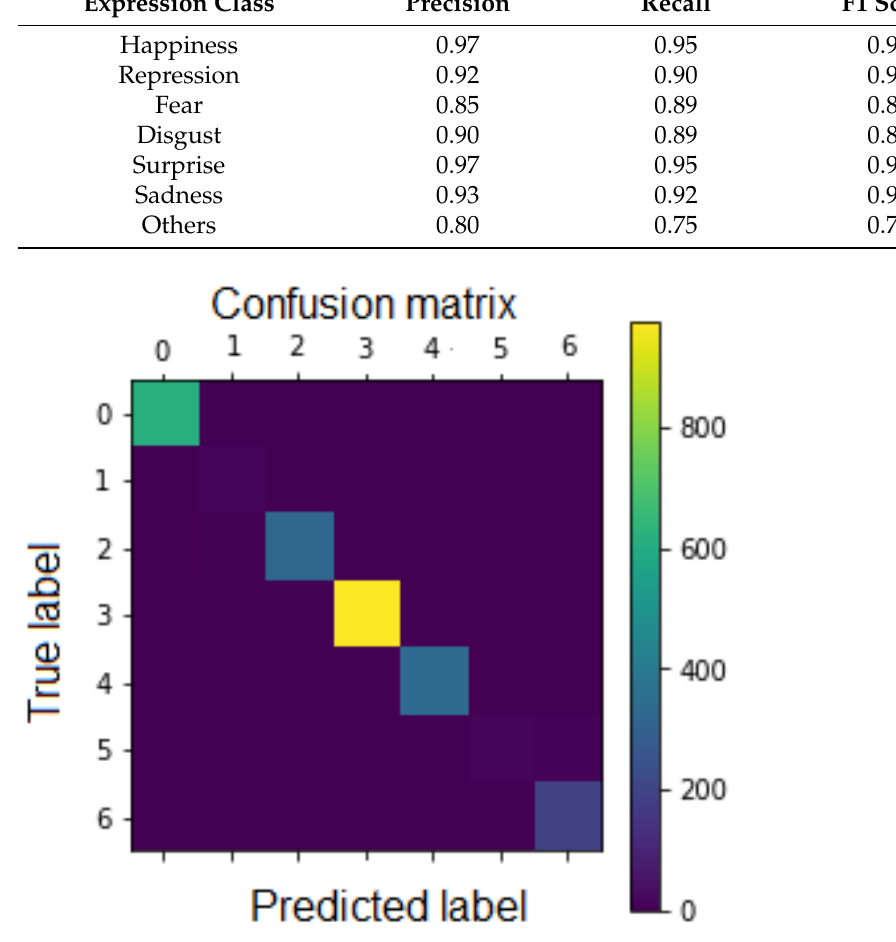
Figure 10. Confusion matrix on testing